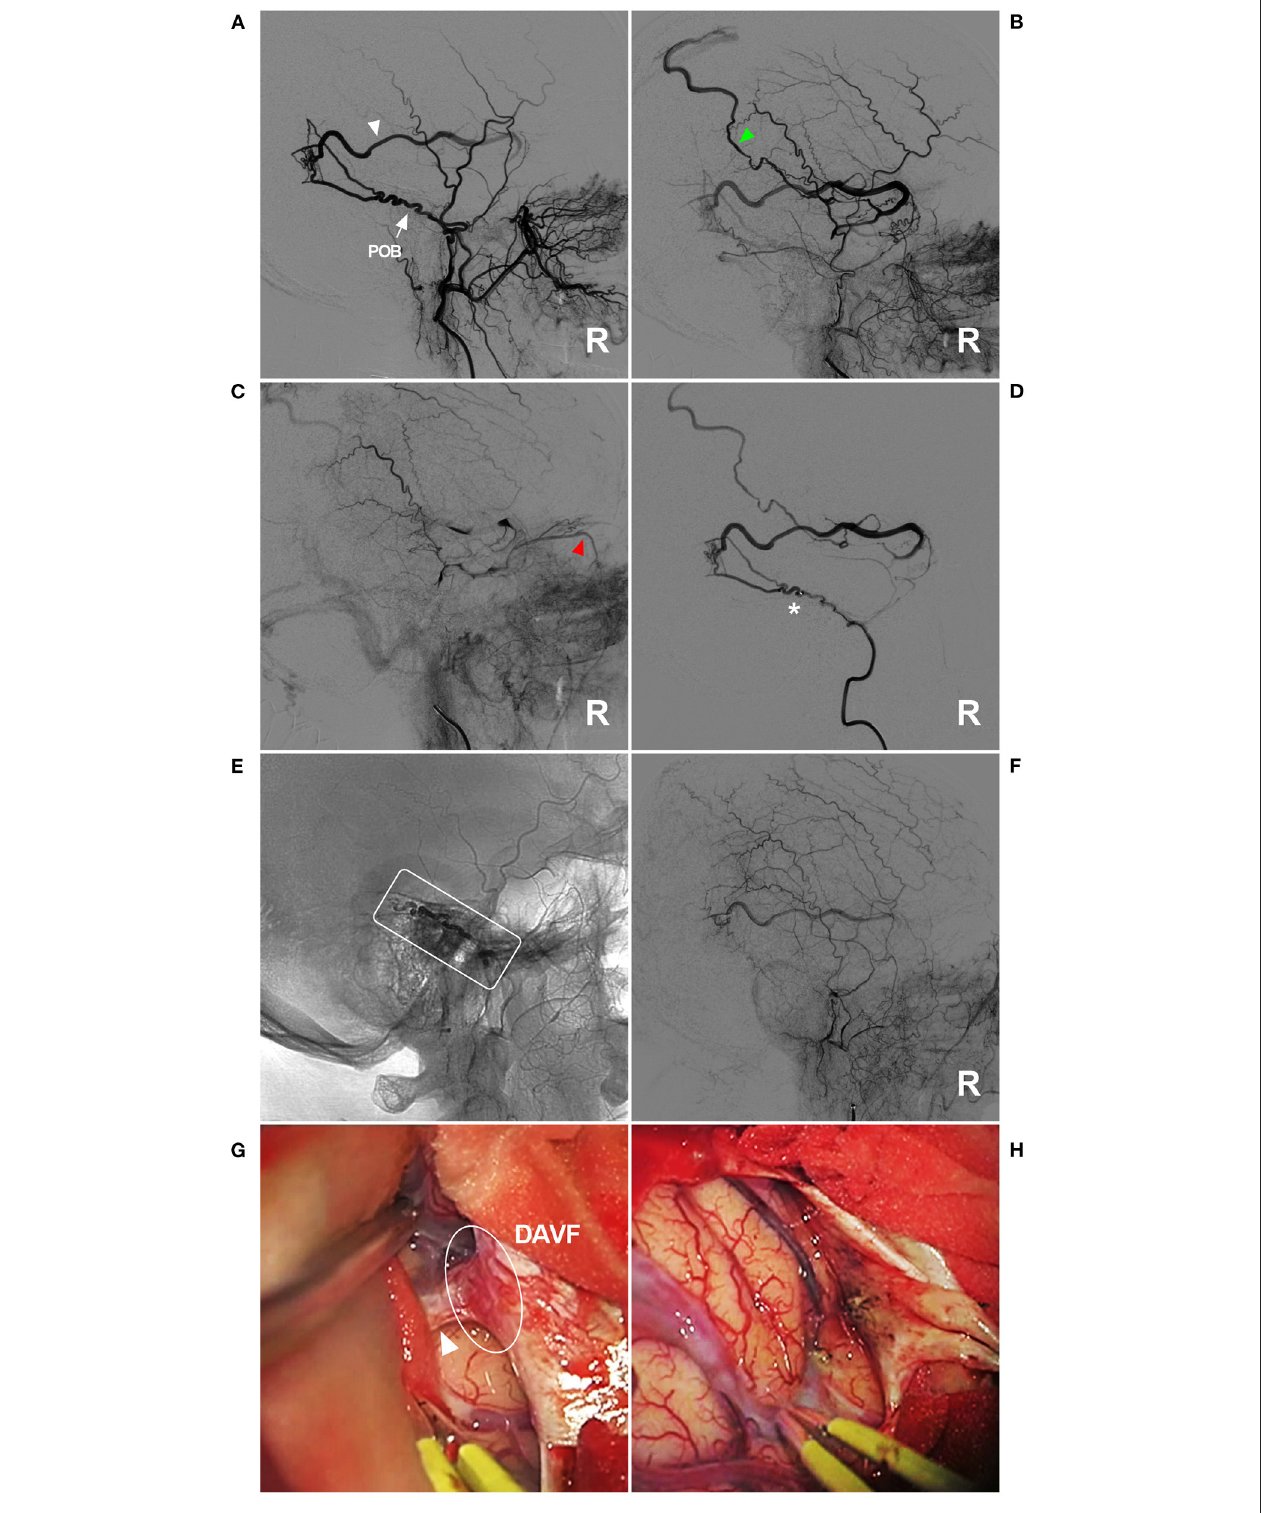
FIGURE 7 | Unsuccessful type IIb EVT for a DAVF in the temporal region. (A–C) Lateral view ECA DSA showed a DAVF in the temporal region supplied by a normally developed and tortuous POB (arrow) (A) . The draining vein behind the Sylvian fissure is clearly shown [white triangle in panel (A) , early arterial phase] draining to